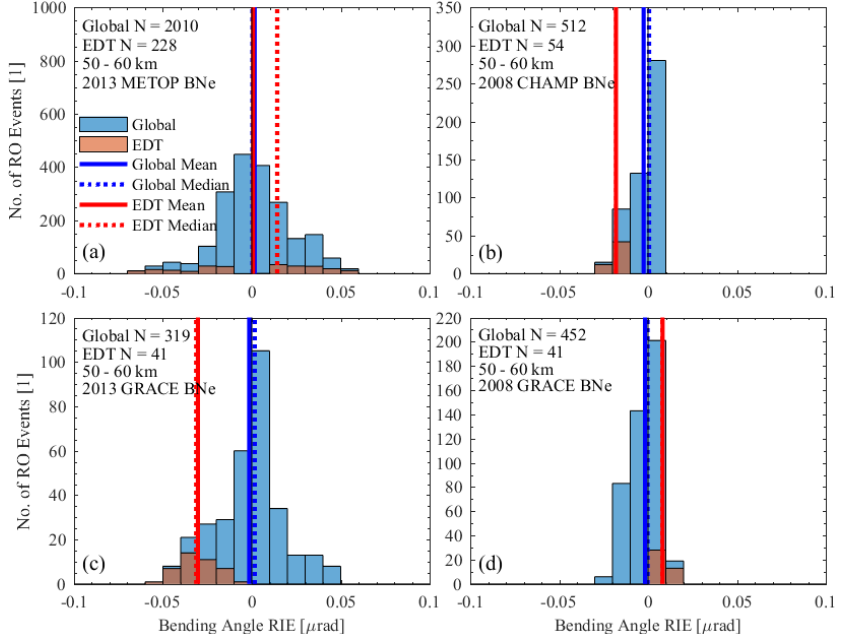
Figure 10. Relationship between the histogram distribution of the number of RO events and the average value of the bi-local BNe term over 50–60 km impact altitude range for high solar activity data (left column, MetOp-A/-B ( a ) and GRACE ( c ) on 15 May and 15 July 2013) and low solar activity data (right column, CHAMP ( b ) and GRACE ( d ) on 14–16 July 2008). In each panel, the global (blue) and EDT (red) ensembles are presented as well as the global mean, global median, EDT mean, and EDT median as vertical lines in the corresponding colors (see legend in panel ( a )).